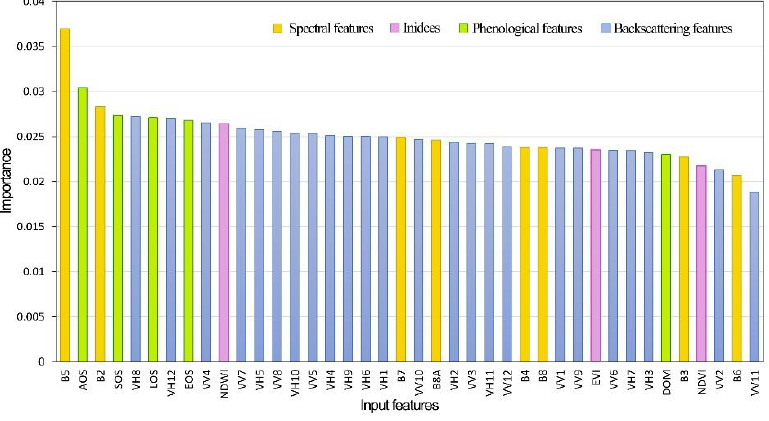
Figure 9. Importance of input features for the RF model.